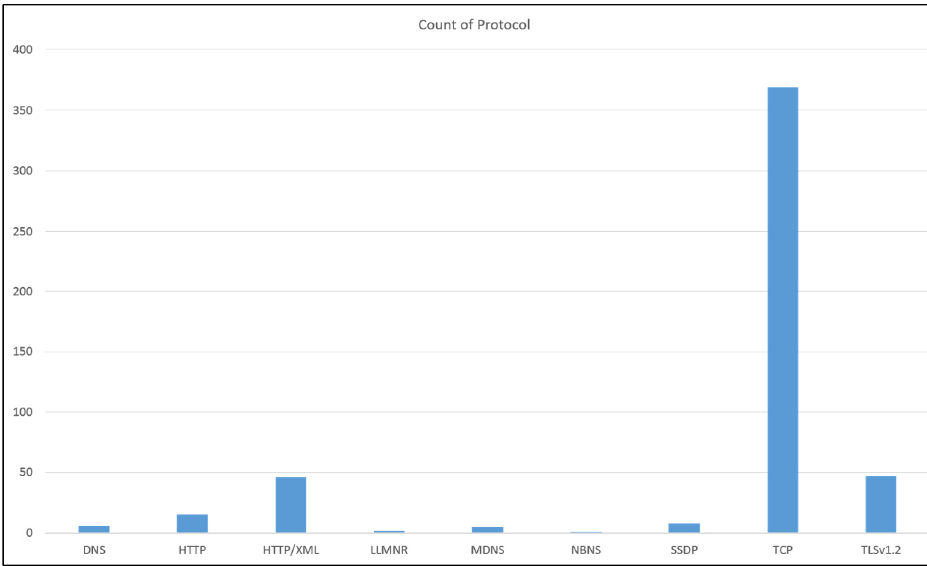
Figure 14. SNORT log file in Wireshark.